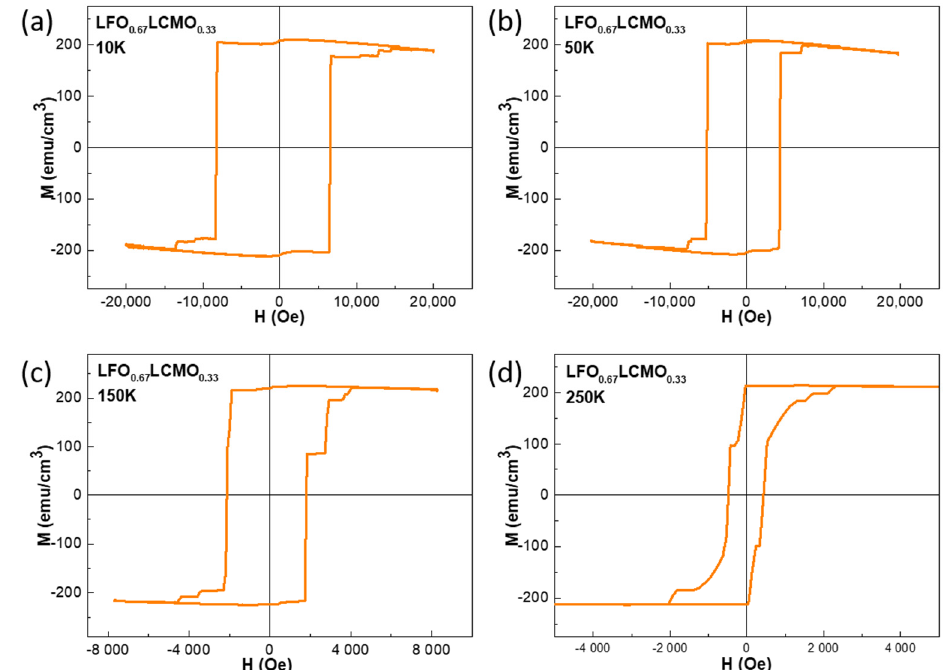
Figure 3. The magnetization hysteresis (M-H) loops of the LFO 0.67 LCMO 0.33 film measured at ( a ) 10 K, ( b ) 50 K, ( c ) 150 K and ( d ) 250 K. BasedontheM-Hcurves, theEBfield(H EB =|H + +H − |/2), coercivity(H C = |H + + H −